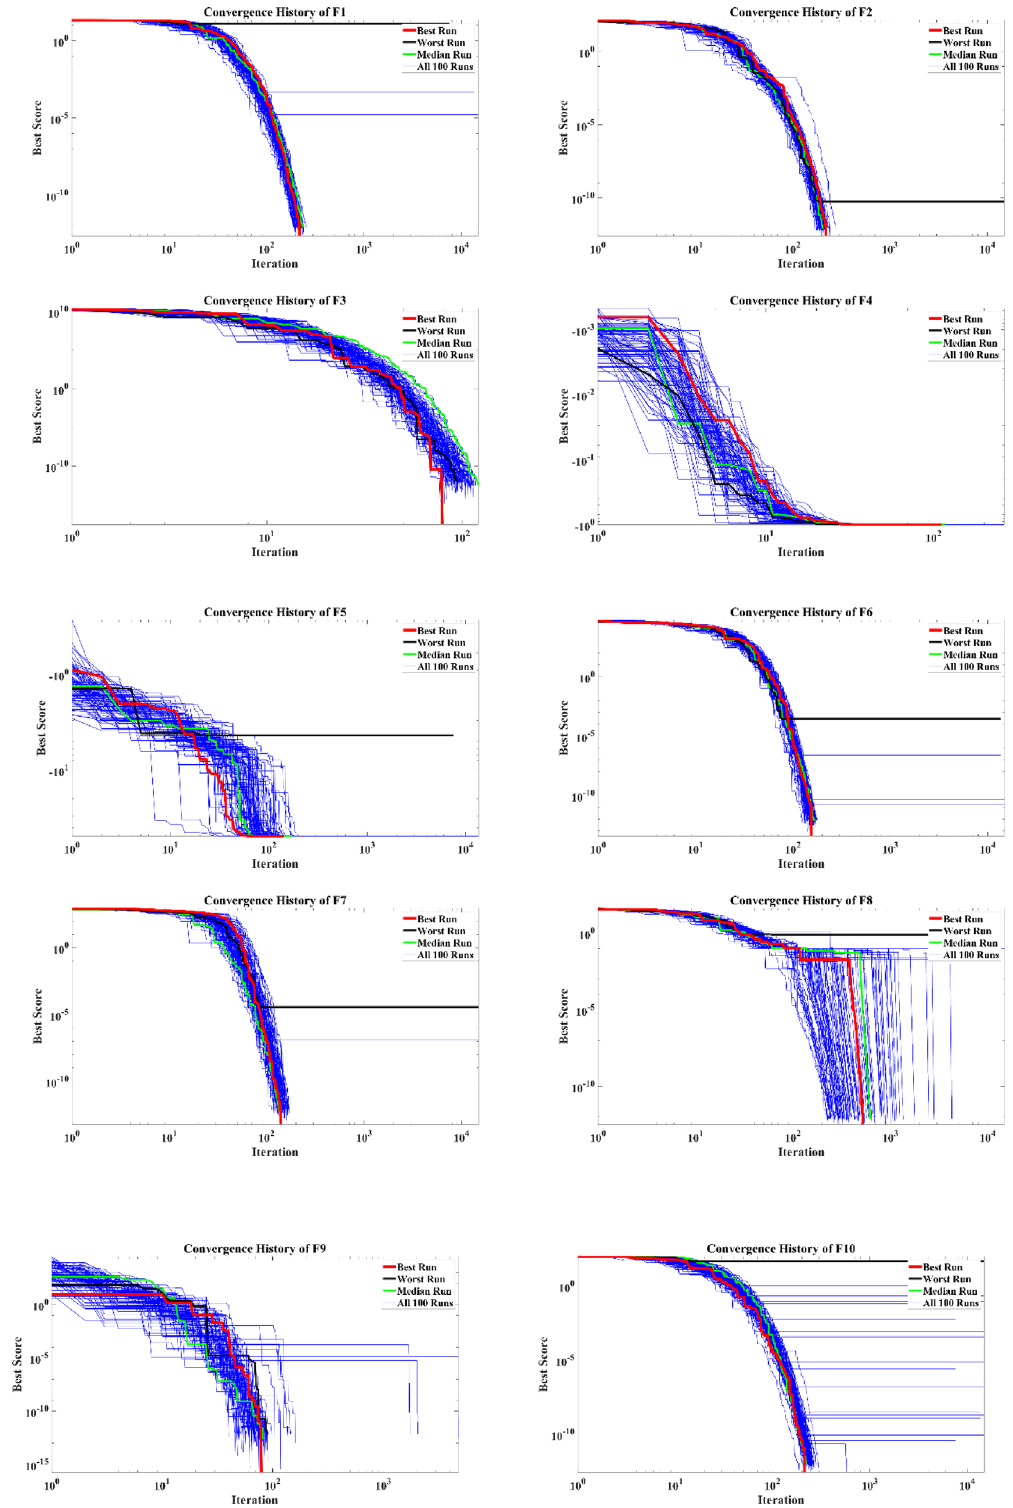
Figure 5. Convergence curves of the EVO for the mathematical